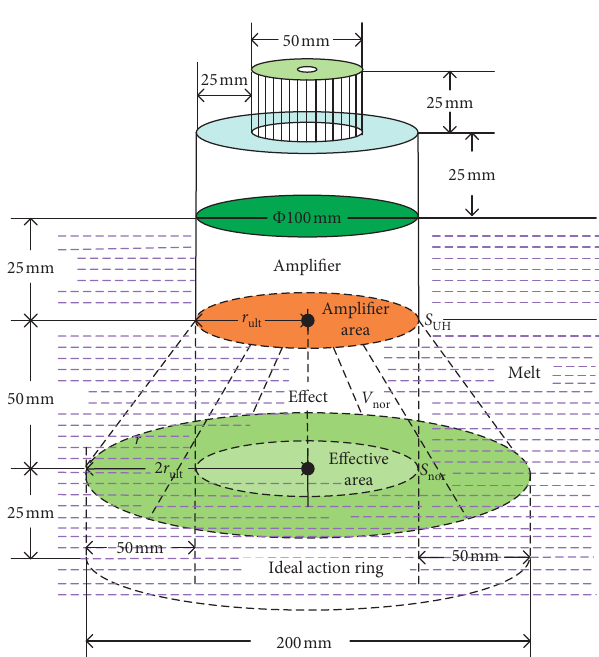
Figure 2: Diagram of traditional ultrasonic vibration network horn action.